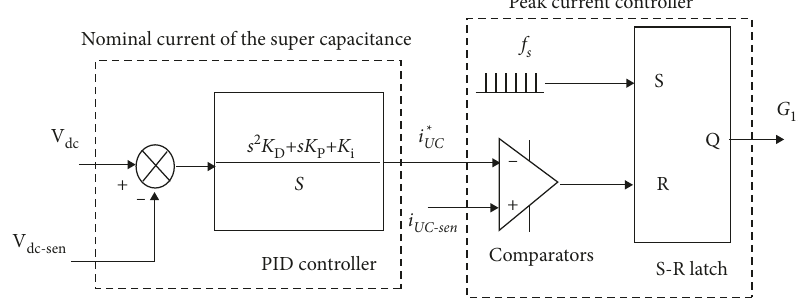
Figure 4: Topology of a DC/DC converter with an integrated magnetic structure.